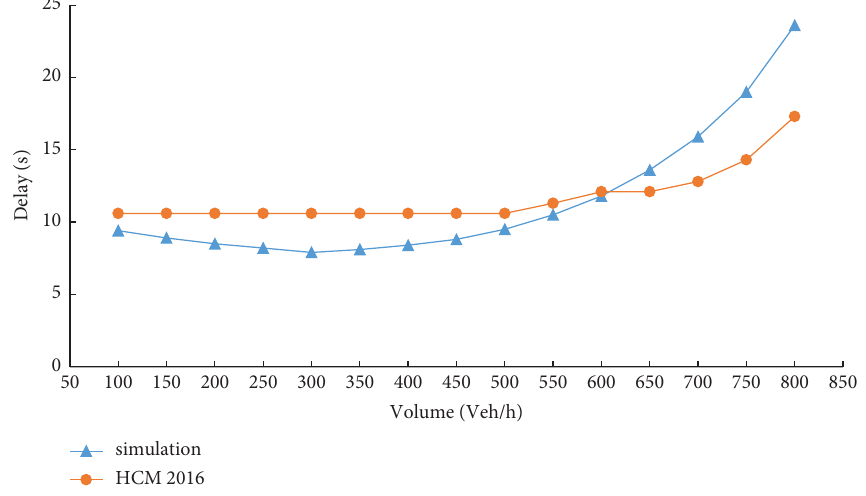
Figure 5: Te efect of volume variations on delay for a single right-turn lane.